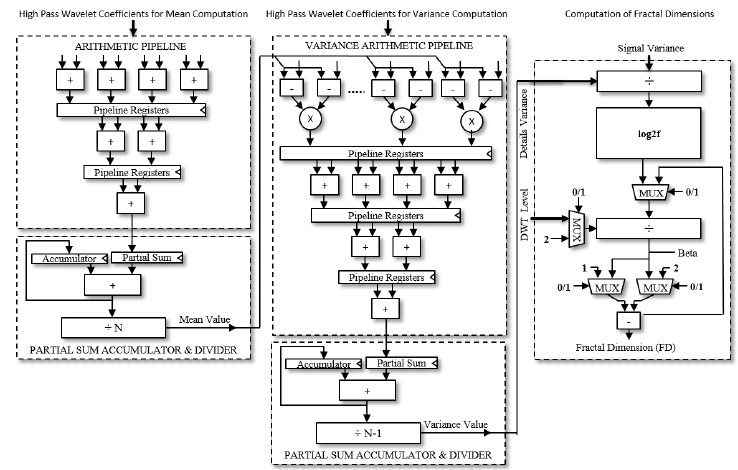
Figure 8. Logic circuit for mean, variance and fractal dimension computations. Algorithm 1: Discrete Wavelet Transform